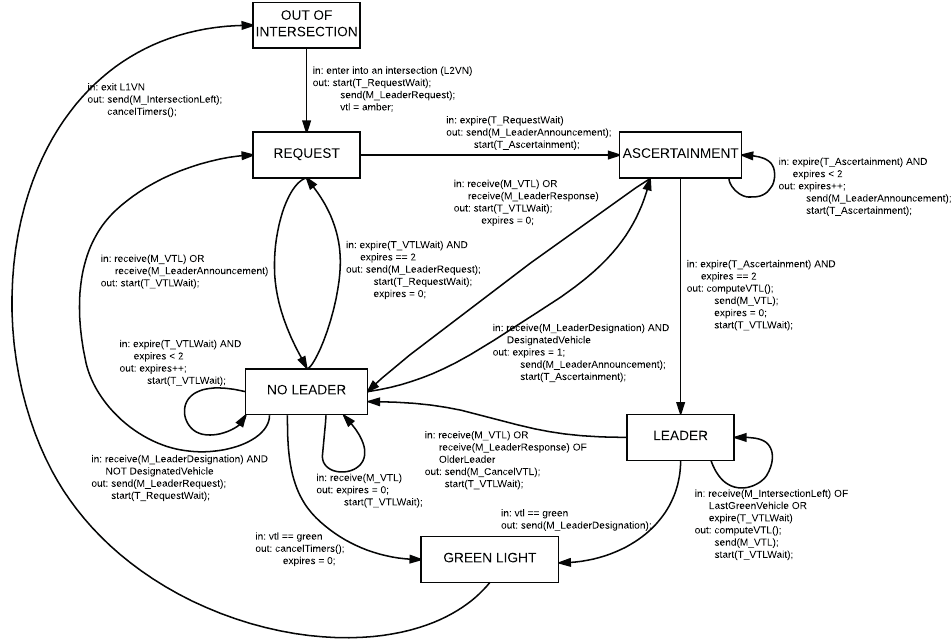
Figure 4. The state machine of the procedure used to choose a VTL